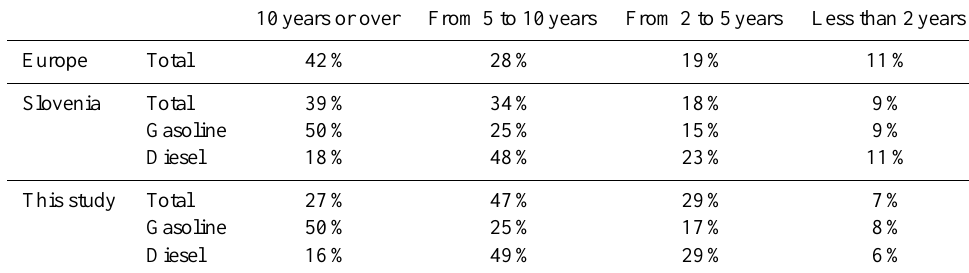
Table 4. Passenger car fleets according to their age, at the end of the year 2011. 10years or